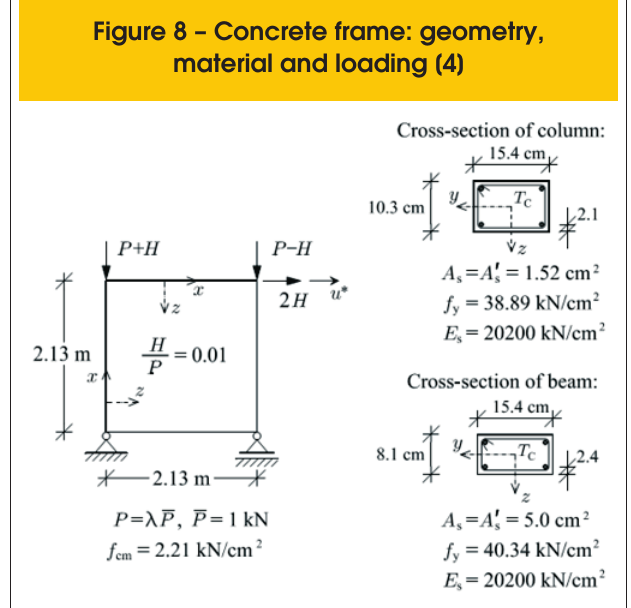
Figure 8 – Concrete frame: geometry, material and loading [4]